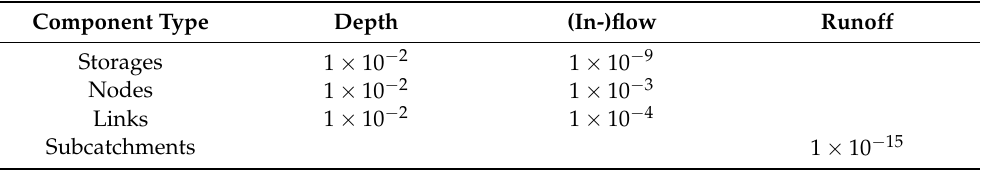
Table A1. Covariances for the considered process noise, depending on the type of modelling